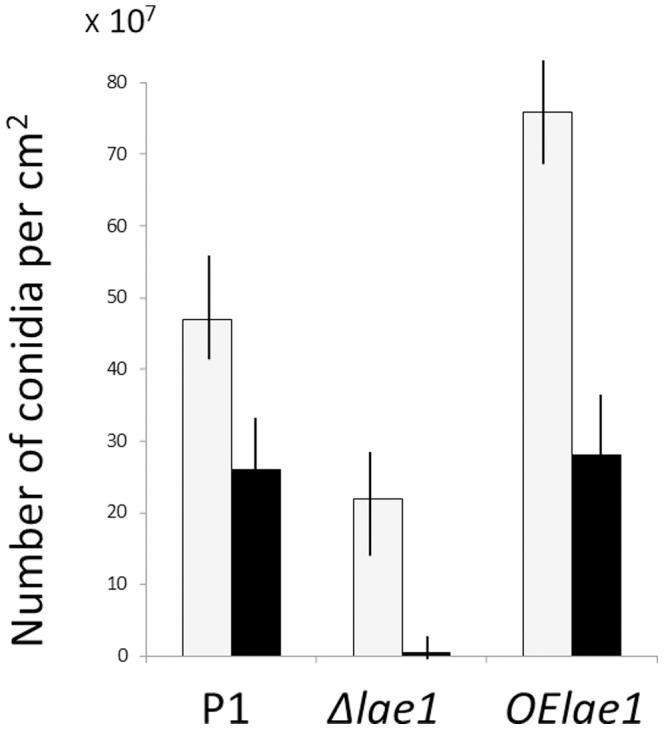
Asexual sporulation of T. atroviride.(A) Quantitation of conidiation of the parent (P1), Δ
lae1-1 and OElae1 strains on PDA in light (white bars) and in darkness (full bars). Values are means of at least three independent biological experiments. Similar investigations with strain Δ
lae1-2 yielded values within ±8% of those of Δ
lae1-1. All values are statistically different by the students t-test (p<0.05).